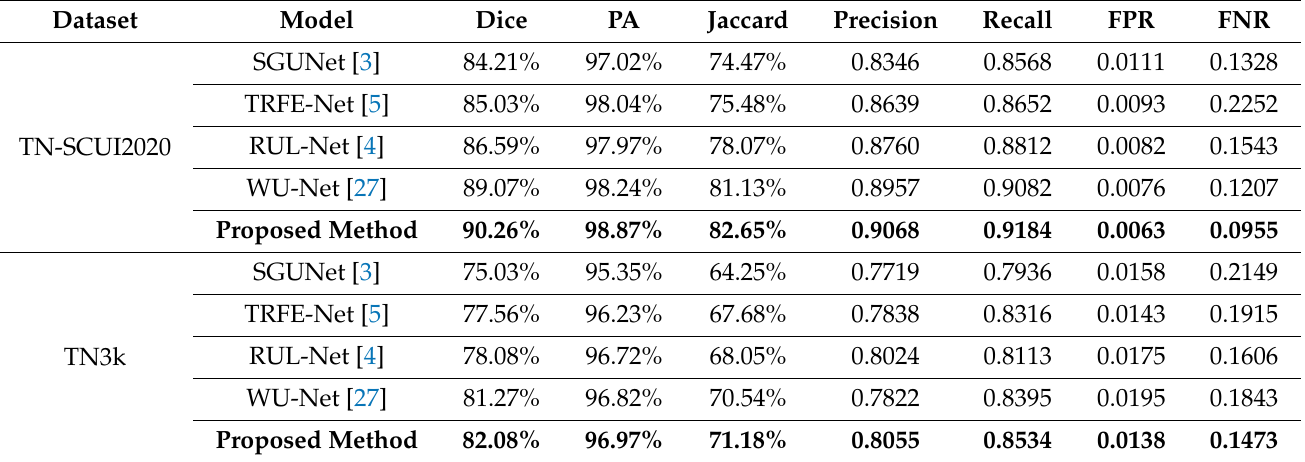
Table 1. Comparison of the results of state-of-the-art thyroid nodule segmentation models on the TN-SCUI2020 dataset and TN3k